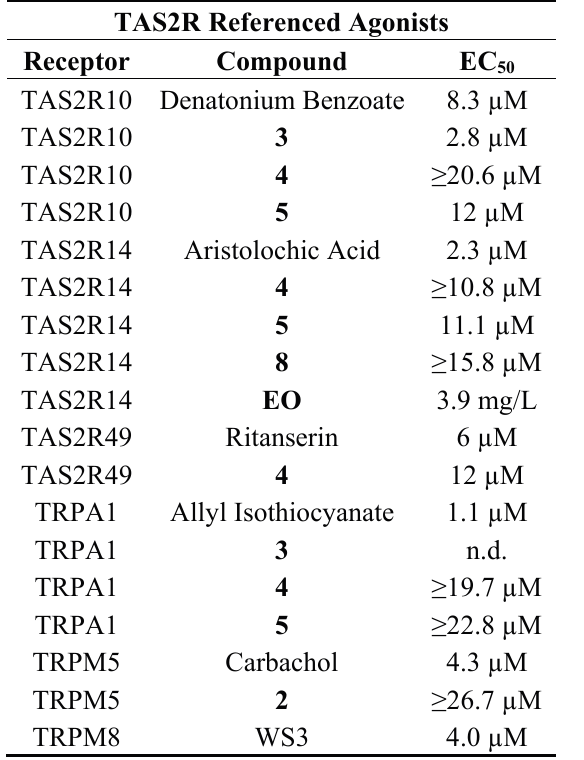
Table 2. List of EC 50 values calculated from the concentration/response analysis performed for all active compounds and the referenced